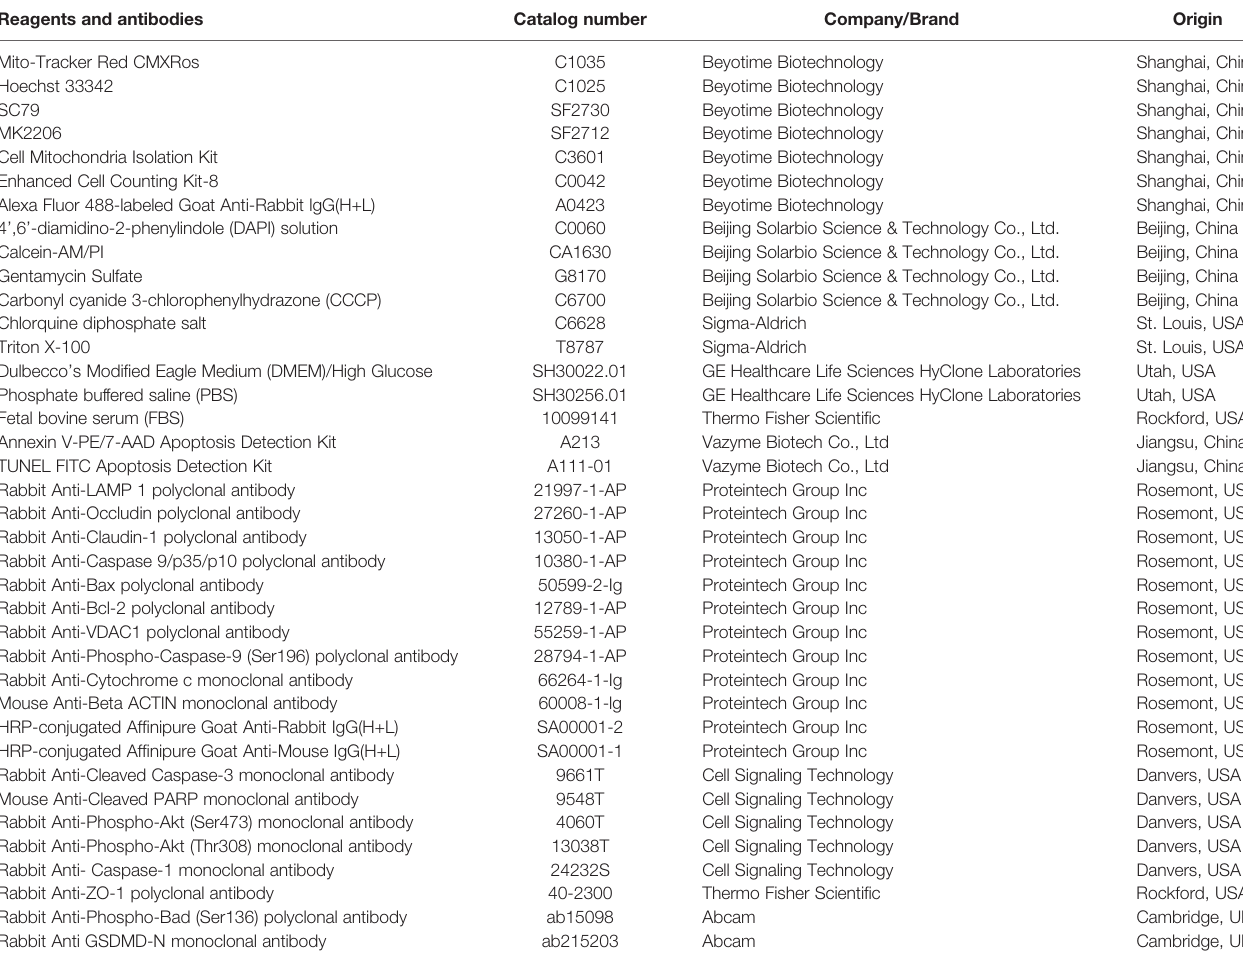
TABLE 1 | Reagents and